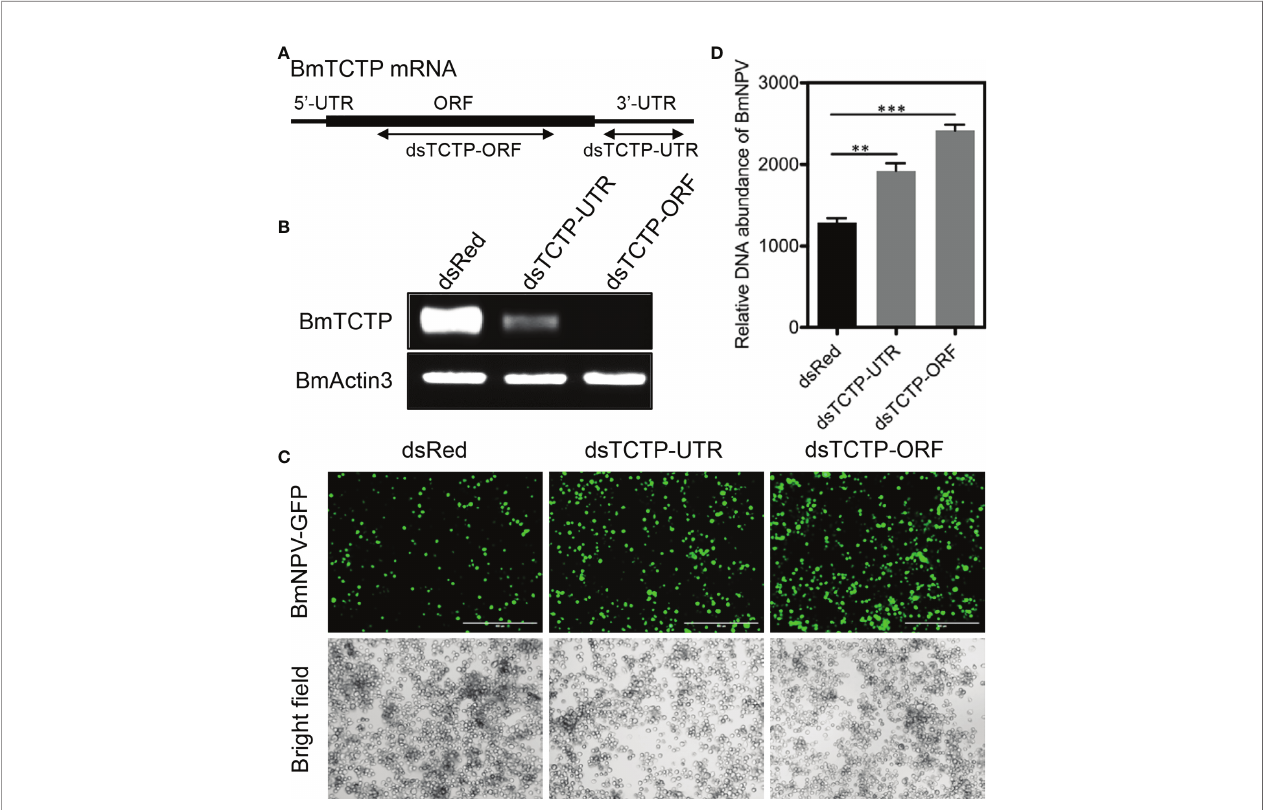
FIGURE 2 | Bombyx mori translationally controlled tumor protein ( BmTCTP ) knockdown promoted viral replication. (A) Schematic representation of the silkworm BmTCTP gene structure and dsRNA target regions. (B) Semiquantitative RT-PCR was used to evaluate RNAi ef fi ciency of dsRNA targeting TCTP-ORF and TCTP- UTR in cultured silkworm BmN cells. The expression of BmActin3 gene was used as an internal control. (C) Fluorescence microscopy was used to observe the viral amounts when BmN cells were infected with Bombyx mori nucleopolyhedrovirus (BmNPV)-GFP for 72 h in the presence or absence of BmTCTP . Scale bar, 400 m m. (D) The viral DNA contents were detected by quantitative RT-PCR analysis of the BmNPV GP41 gene. The expression of BmGAPDH gene was used as an internal control. The data presented are the means ± SD (n = 3). For the signi fi cant analysis: **P < 0.01 and ***P <